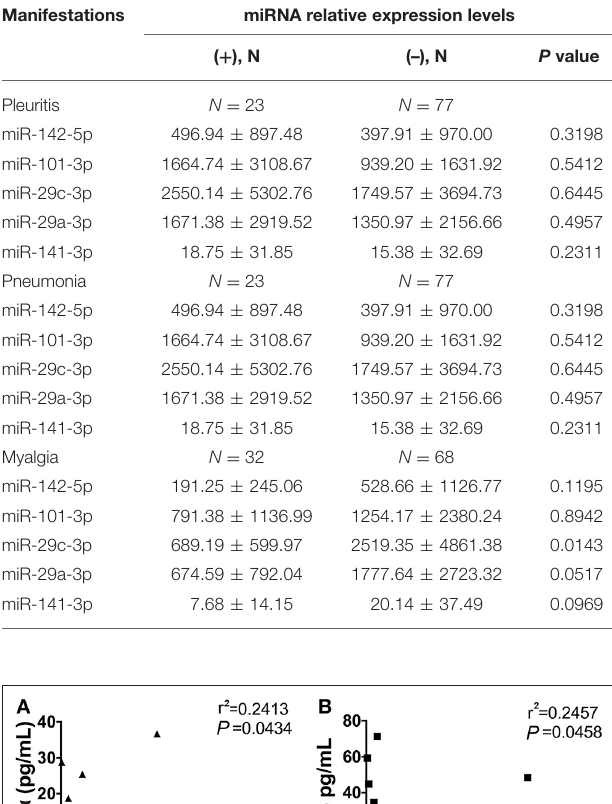
TABLE 2 | Comparison of plasma miRNA levels according to disease manifestations in 100 patients with AOSD.